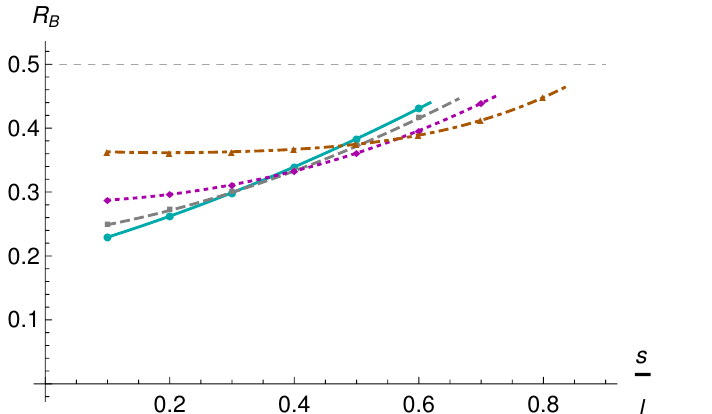
Figure 17 . The ratio of the wedges E W ( A : B ) /E W ( A : BC ) in the S B phase for the D p -brane geometries as a function of s/l .